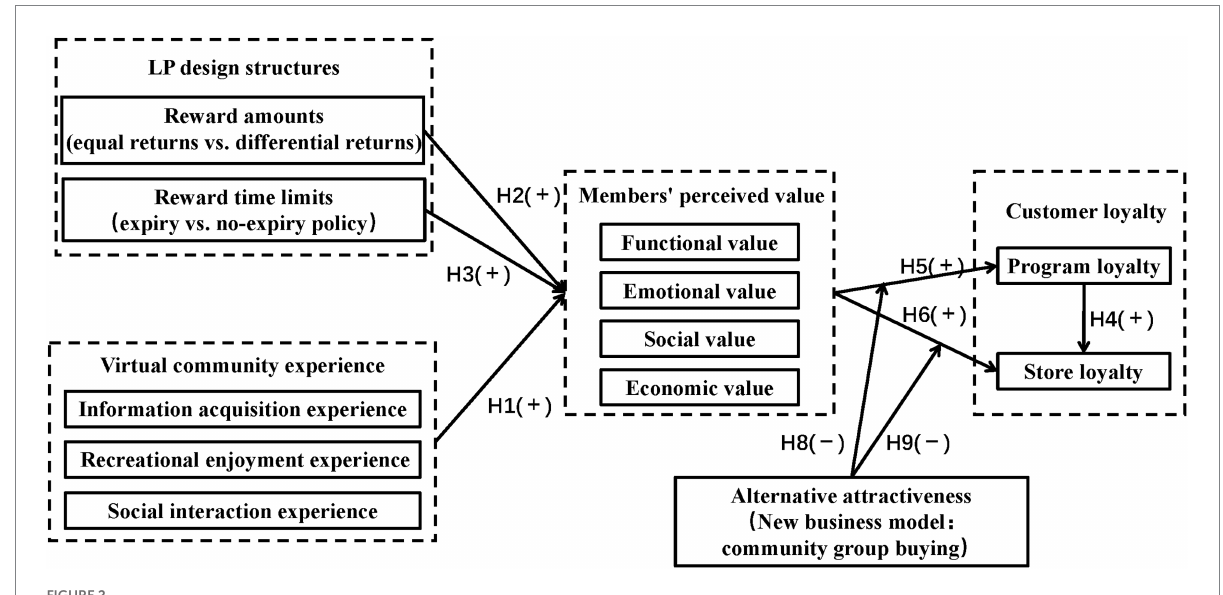
FIGURE 2 Conceptual